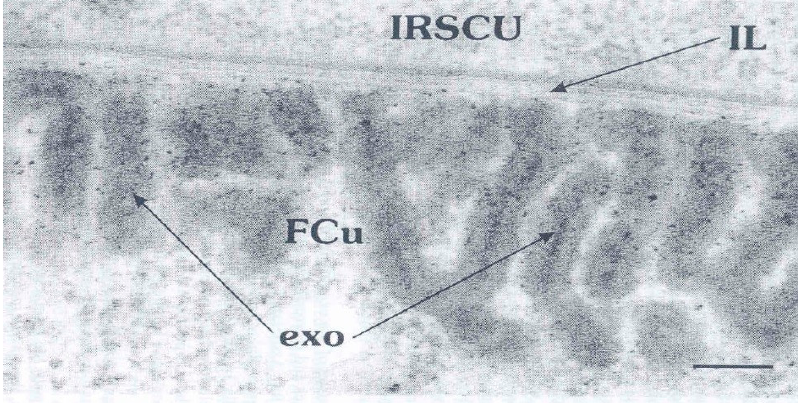
Figure 4. Late stage of exocuticle (exo) formation in a cuticle cell (FCU) adjacent to inner root sheath cell (IRSCU) and separated by an intercellular CMC layer (IL). Note the inner dark straining in the exocuticle laminathat might be A-layer protein. This stage is markedly different from that in Figure 3. Provided by Dr. L Jones